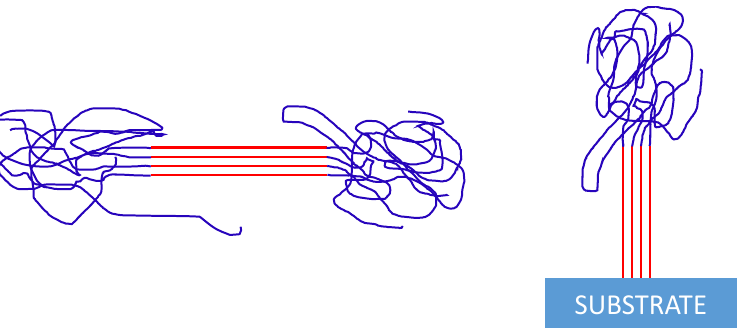
Figure 1. Schemes for a “bunch of flowers” of several polymer chains, which are partially involved in the formation of a nucleus (correlated stems) and partially staying amorphous (“bloom”).